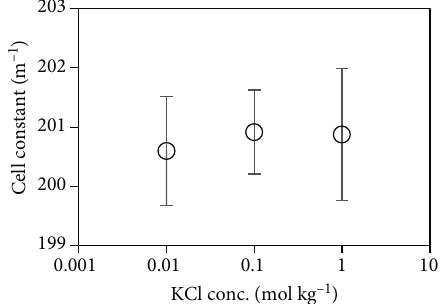
Figure 4: Obtained cell constants of NMIJ secondary Jones-type cell calibrated using 3 NMIJ CRMs (0.01molkg -1 , 0.1molkg -1 , and 1molkg -1 of KCl aqueous solutions). The bars were expanded uncertainties ( k = 2 ) which were estimated by the combination of the following uncertainties: resistances of the LCR meter (0.025%), thermometer (0.008%), measurement repeatability (less than 0.1%), and the certi fi ed value of NMIJ CRMs. The uncertainty of NMIJ CRMs (0.01molkg -1 , 0.1molkg -1 , and 1molkg -1 of KCl aqueous solution) was 0.28%, 0.16%, and 0.23%,